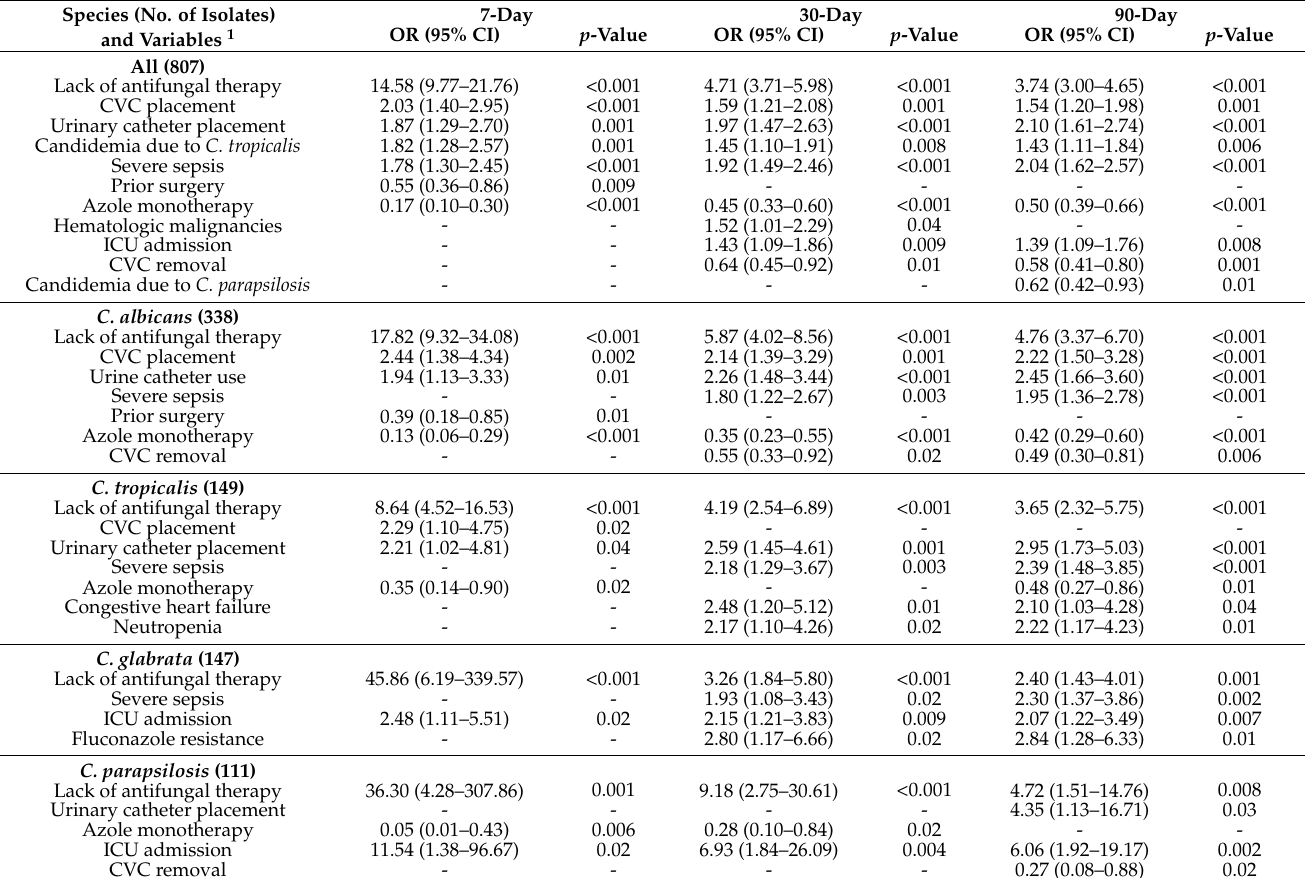
Table 2. Multivariate analysis of predictive factors related to 7-, 30- and 90-day mortalities of all candidemia patients according to the Candida